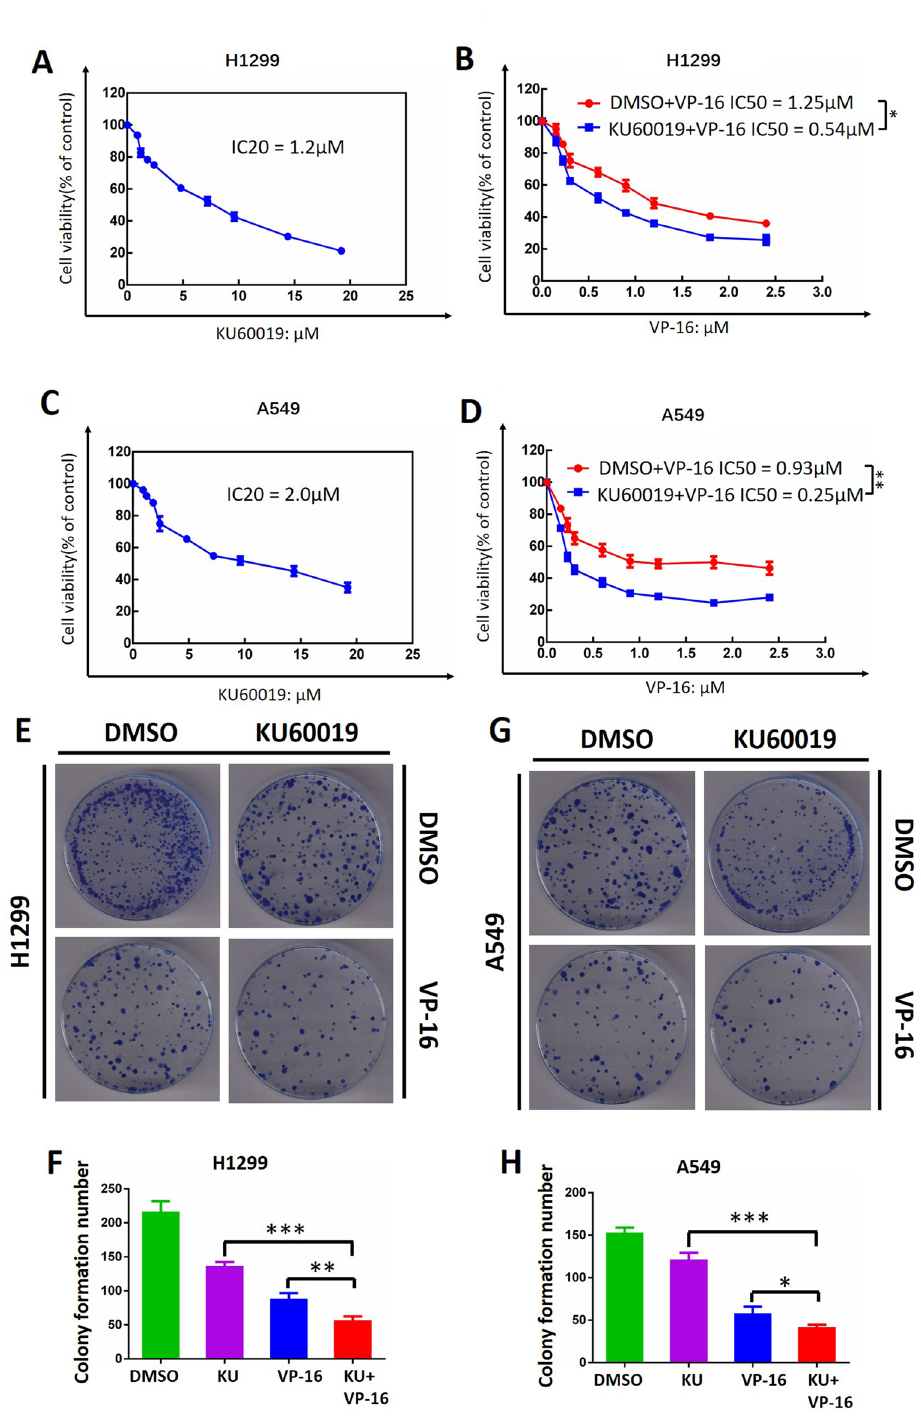
Figure 5. KU60019 Combined with VP-16 suppressed the survival of lung cancer cells. ( A , C ) Cells were treated with the indicated concentrations of KU60019 for 72 h, followed by the ATP-lite assay. ( B , D ) Cells were treated with various concentrations of VP-16 or in conjunction with an IC 20 concentration of KU60019 and subjected to the ATP-lite assay. ( E – H ) H1299 and A549 cells were plated in triplicate in 60-mm dishes and treated with VP-16 (0.5 μM) alone or in conjunction with RG7112 (1 μM). After 10–14 days, colonies were stained and counted (> 50 cells in a colony). All experiments were independently repeated three